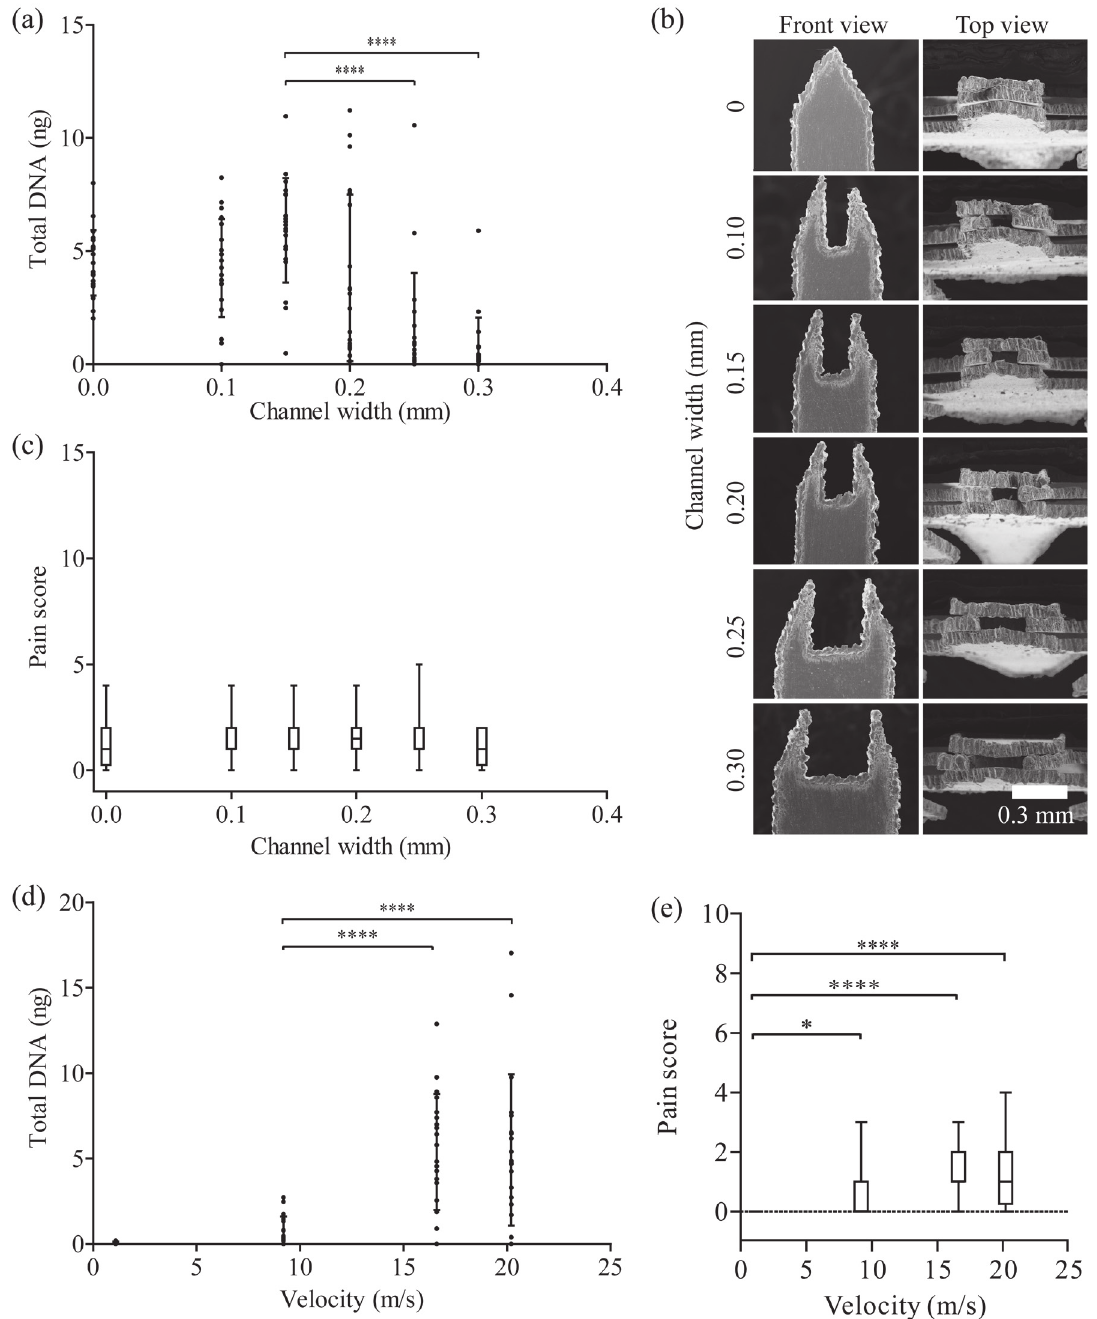
Figure 2. Microbiopsy channel width and velocity optimisation. Channel width and velocity were varied to optimise the microbiopsy device configuration. Total DNA was used as a surrogate for sample size. Panel ( a ) shows the DNA extracted from device with varying channel width and that the maximum amount of DNA was collected with 0.15 mm channel width. Panel ( b ) displays high resolution scanning electron microscopic images showing different channel widths of the microbiopsy device. Panel ( c ) shows the level of pain volunteers reported when different channel width microbiopsies were used. Panel ( d ) shows the varying velocity applied and that the maximum amount of DNA was collected when the device was applied at 16.6 m/s. Panel ( e ) shows the level of pain volunteers reported when application velocity was